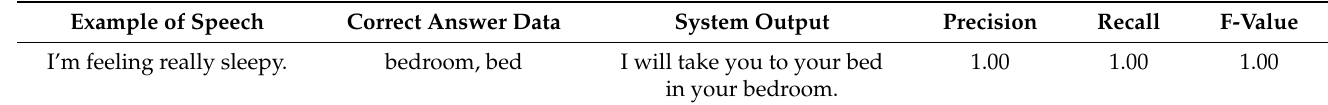
Table 5. Examples of correct utterances and system output.